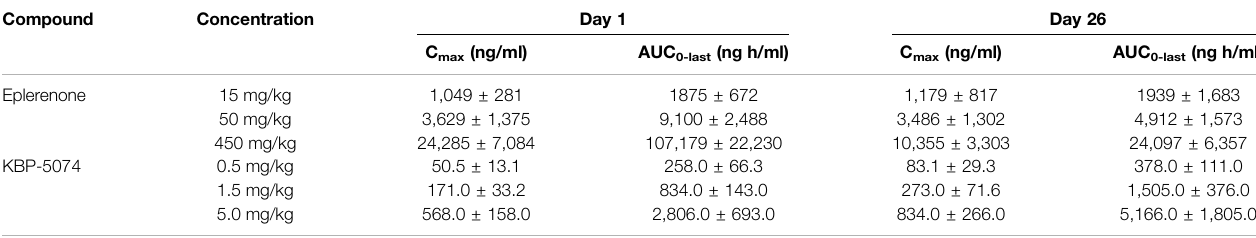
Data expressed as mean ± standard error of the mean. AUC